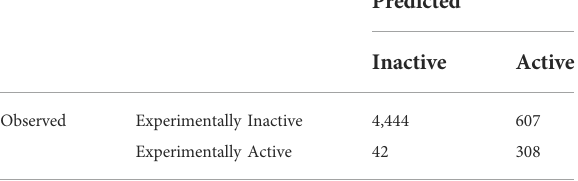
TABLE 3 Confusion matrix of the estrogen antagonist ER model results whenlookingatallCERAPPevaluation setsubstanceswith four or more data